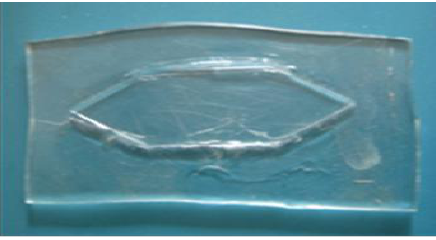
Figure 8. An unsuccessful sample showing the partial melting phenomenon along the edge, blisters, pitting, wrinkling and yellow dots on the product